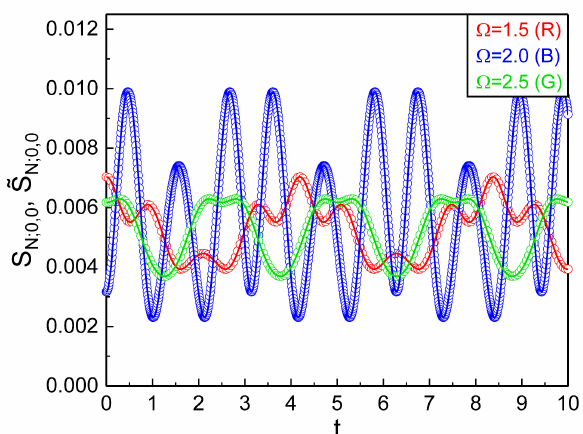
( t ) (solid lines) and N ;0,0